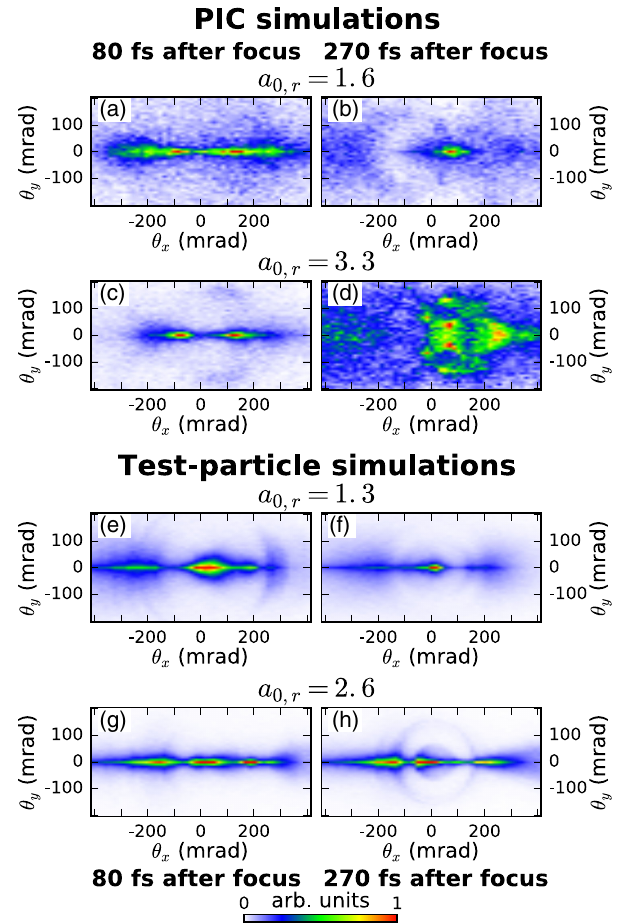
FIG. 10. 3D-PIC simulations. (a) – (d) Angular distribution of electrons with z > 0 initially, with (a,b) a 0 ;r ¼ 1 . 6 or (c,d) a ¼ 3 . 3 . The distributions are shown either approximately 0 ;r 80 fs after reflection or approximately 270 fs after reflection, which corresponds to the end of the simulation. In these images, a value of 1 on the color bar corresponds to 1 . 34 fC = mrad 2 for panel (a), 1 . 66 fC = mrad 2 for panel (b), 8 . 86 fC = mrad 2 for panel (c), and 1 . 85 fC = mrad 2 for panel (d). (e) – (h) Similar angular distributions reproduced in test-particle simulations. The laser intensity is slightly reduced in the test-particle simulations to take into account the energy absorption by the plasma